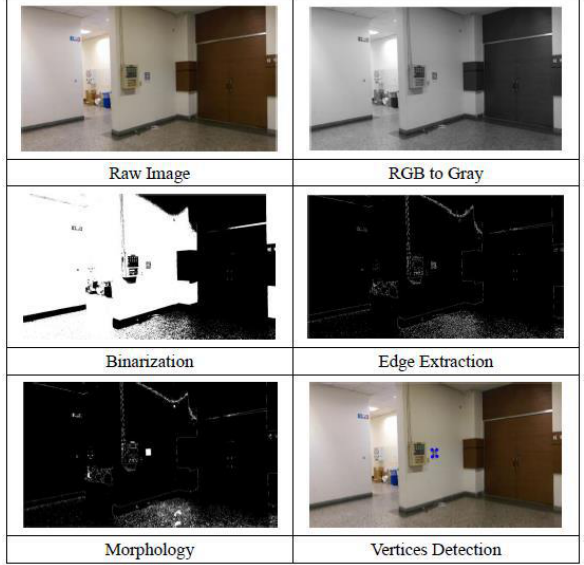
Figure9. The result of the image recognition